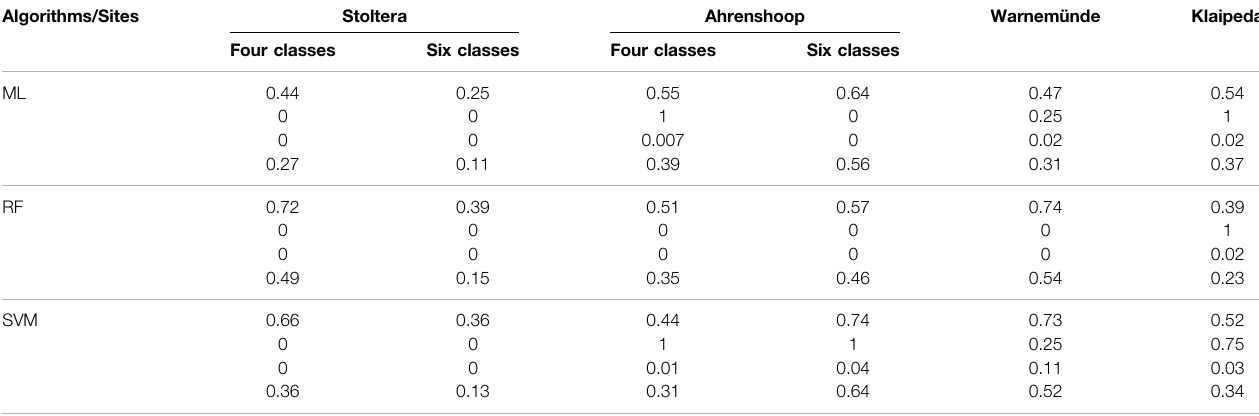
TABLE2| Accuracyofimageclassi fi cationon100 mbeachtransectsat10 m fl ightheightwith4and6classes(litter,vegetation,algae,stones,shellsandsand)foreachsite, algorithmand fl ightheight.Thevaluesarepresentedaspercentagefromtoptobottom:TotalAccuracy(TA),Producer´saccuracy(PA)oflitterclass,User´saccuracy(UA) of litter class and kappa value of agreement (k).